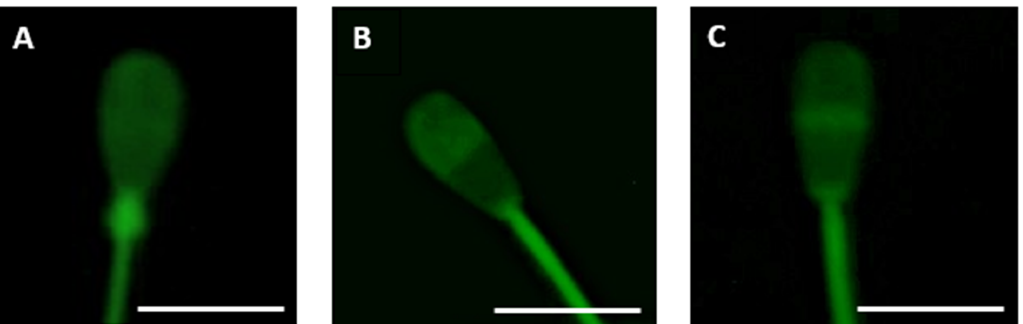
Figure 2. Fluorescence intensity of CTC-Ca 2+ -membrane-bound complex in bull spermatozoa was detected by CTC fluorescence probe. ( A ) non-capacitated sperm cell; ( B ) capacitated sperm cell; ( C ) acrosome-reacted sperm cell. Scale bar: 7 µm. The fluorescence patterns of a minimum of 200 sperm were scored in each experimental group. All slides were kept at room temperature in light-shielded containers until examination. The sample on the slide was divided into quadrants with 6–8 separate fields being examined per quadrant.